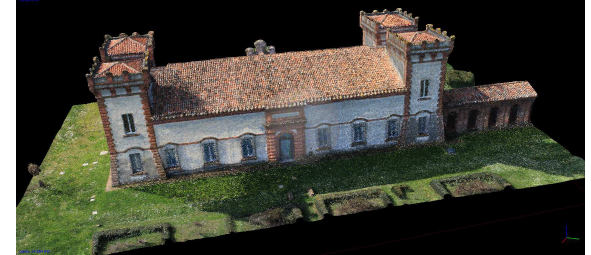
Figure 19. Back view of the final model.